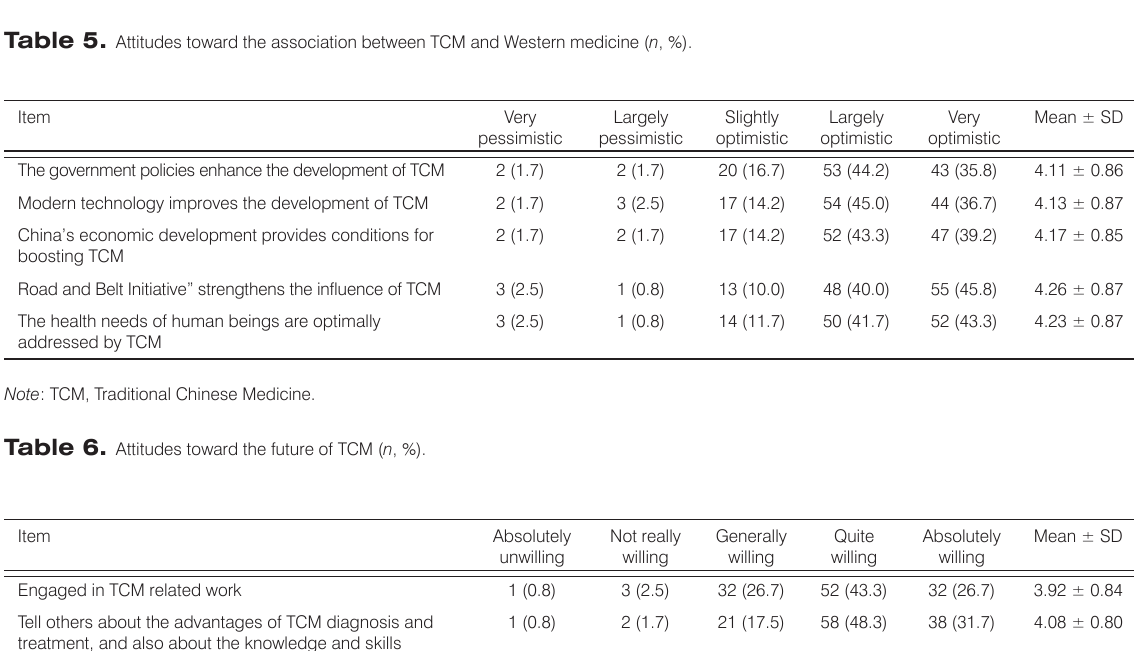
Table 5. Attitudes toward the association between TCM and Western medicine ( n , %).